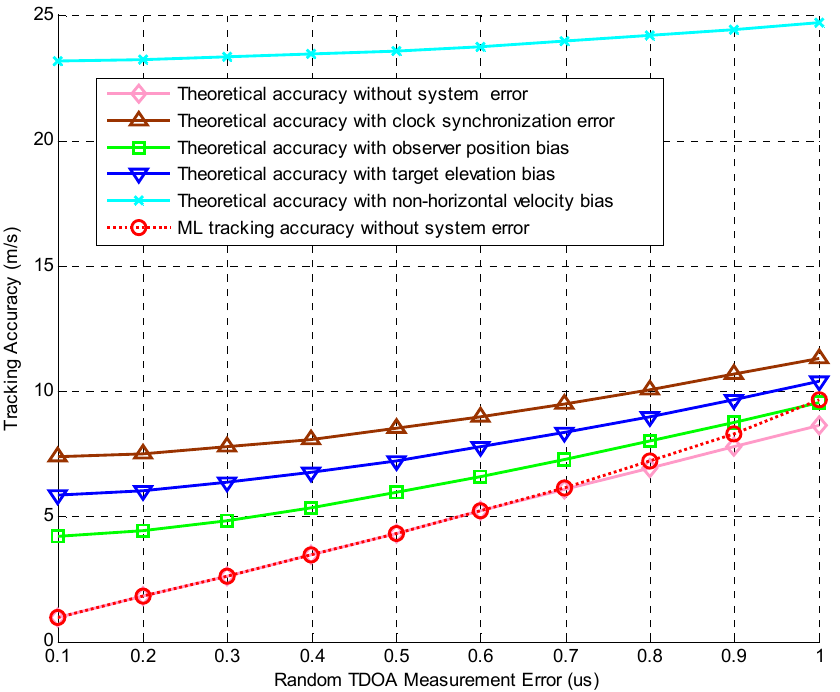
Figure 9. Localization accuracy comparison using LEO satellite, airplane and ground station by var- ying TDOA measurement noise.